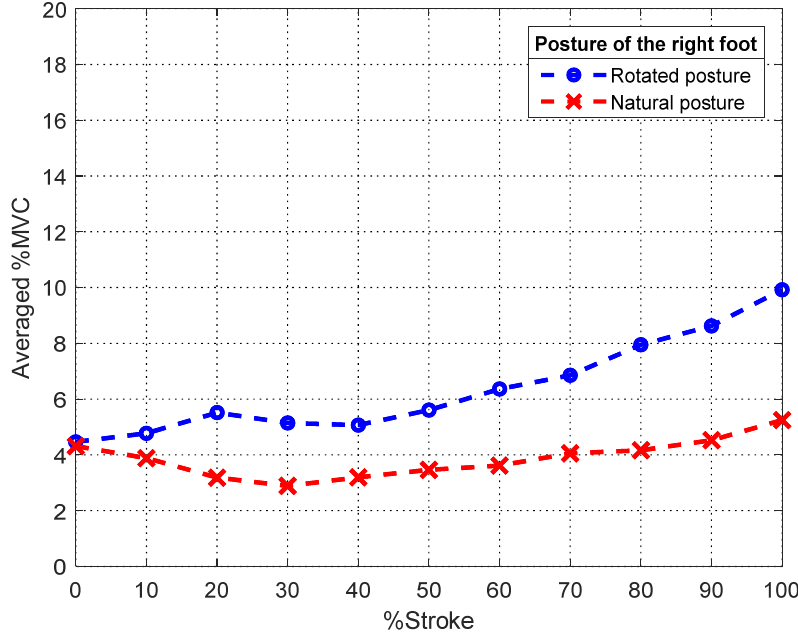
Figure 7. Averaged %MVC for the five muscles for the rotation and natural styles as a function of %stroke (foot posture: p < 0.001; %stroke: p = 0.05).